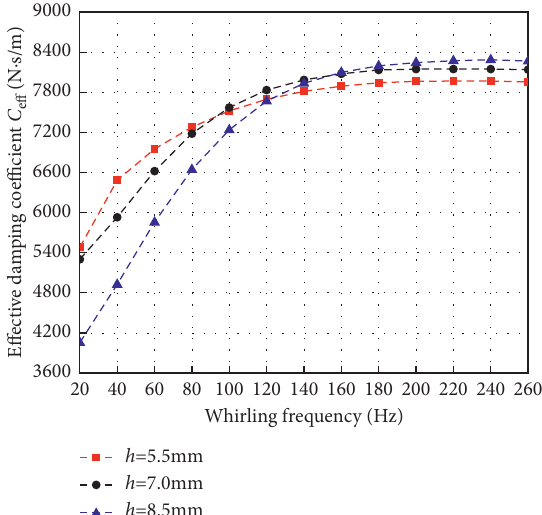
Figure 19: Effective damping coefficient vs. whirling frequency.